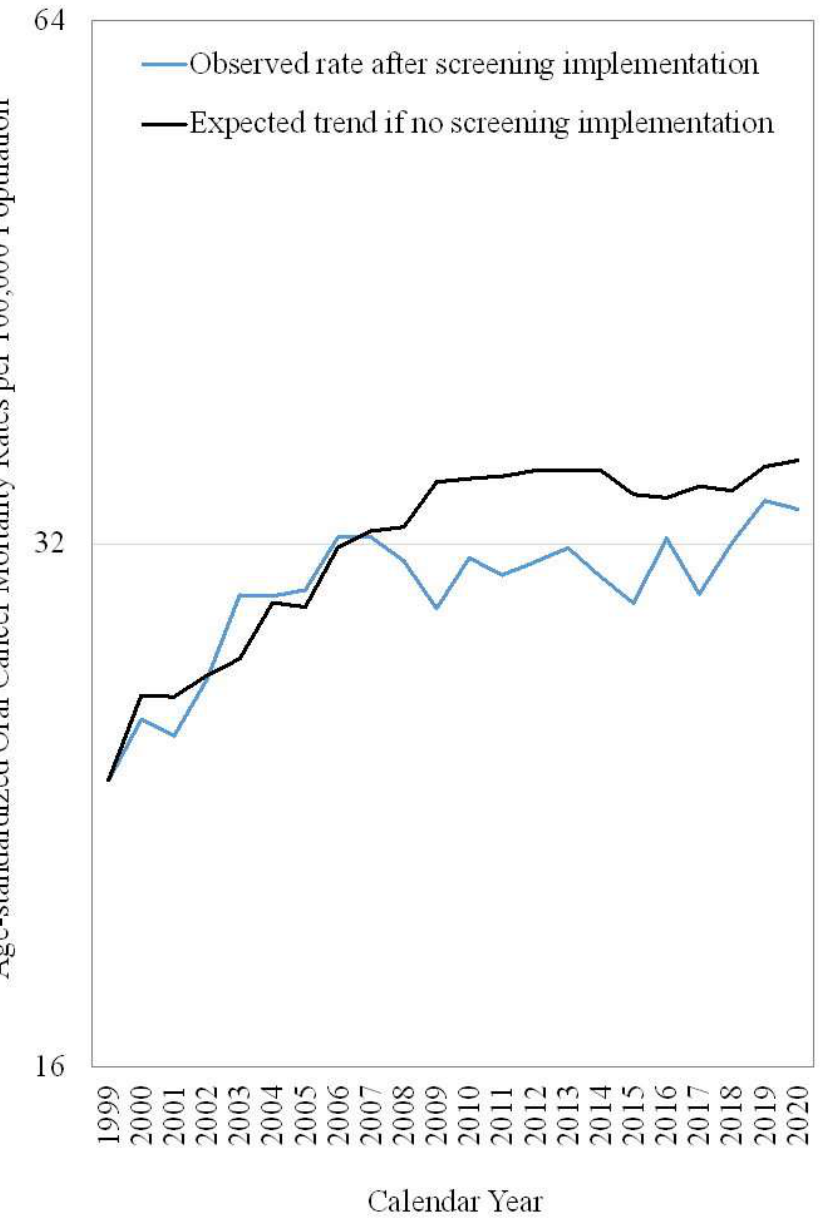
Figure 3. The observed and expected trends of age-standardized oral cancer mortality rate in Taiwanese men between 30 and 64 years old from 1999–2020.